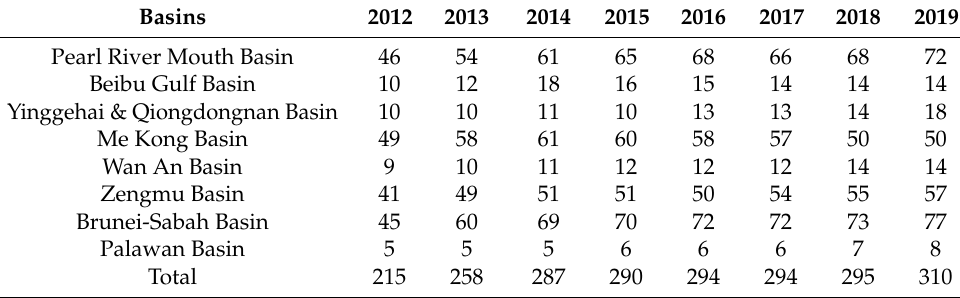
Table 2. Statistics of offshore HE targets in each